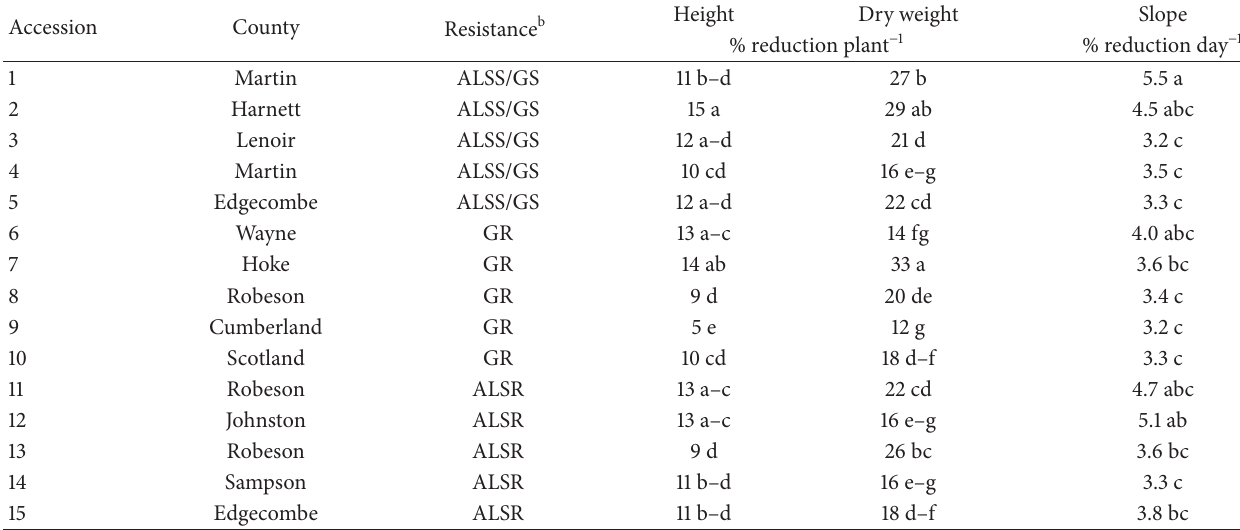
Table 4: Percent reduction in height and dry weight 30 days after emergence and the slopes of regression lines for percentage of reduction in height of 15 Palmer amaranth accessions a